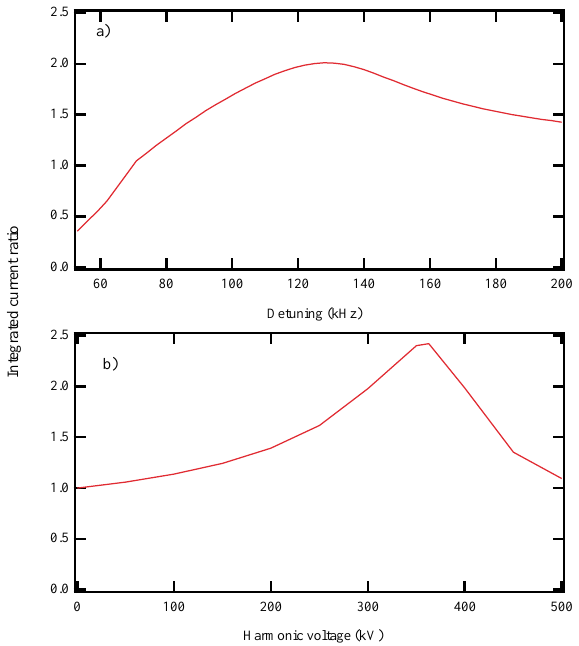
FIG. 9. (Color) Increase in integrated current for an SC cavity with (a) fixed detuning and (b) fixed voltage. typically suffers from very poor lifetime and would benefit greatly from any lifetime improvements.